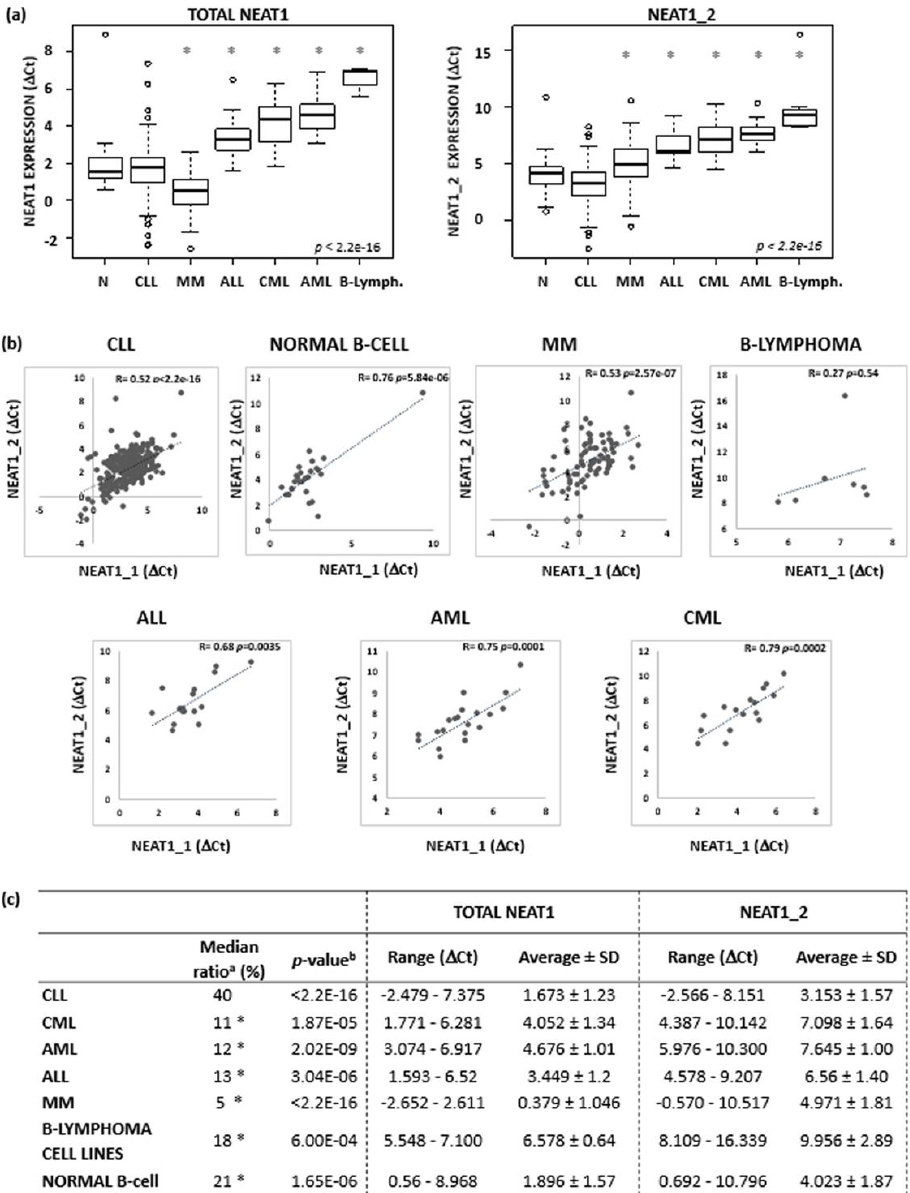
Figure 1. NEAT1 and NEAT1_2 expression levels in normal B-cells and in B-cell malignancies. ( a ) Boxplots of NEAT1 and NEAT1_2 expression levels evaluated by qRT-PCR in 27 normal B-cells, 310 CLL, 82 MM, 16 ALL, 16 CML, and 20 AML samples, and 7 B-lymphoma cell lines (OCILY7, MAVER1, JEKO, MINO, SULTAN, P3HR1, and NAMALWA). Expression data are reported as Ct referred to GAPDH housekeeping gene. Significant differences versus CLL group are indicated by an asterisk (Benjamini-Hochberg adjusted Dunn’s test, p < 0.01). ( b ) Pearson’s correlation on NEAT1_1 (x-axis) and NEAT1_2 (y-axis) expression level expressed as Ct. NEAT1_1 expression values are inferred as described in Appendix B. Correlation coefficient and p-values are reported in each plot. ( c ) Ratios of NEAT1_2 and total NEAT1 expression level; range, average and standard deviation are reported for each group. a Median value of the ratios of NEAT1_2 and NEAT1 expression level evaluated for each sample in the specified subgroups. Significant di ff erences versus CLL group are indicated by an asterisk (Benjamini-Hochberg adjusted Dunn’s test, p < 0.01). b Significant di ff erences of NEAT1 and NEAT1_2 expression levels (Wilcoxon